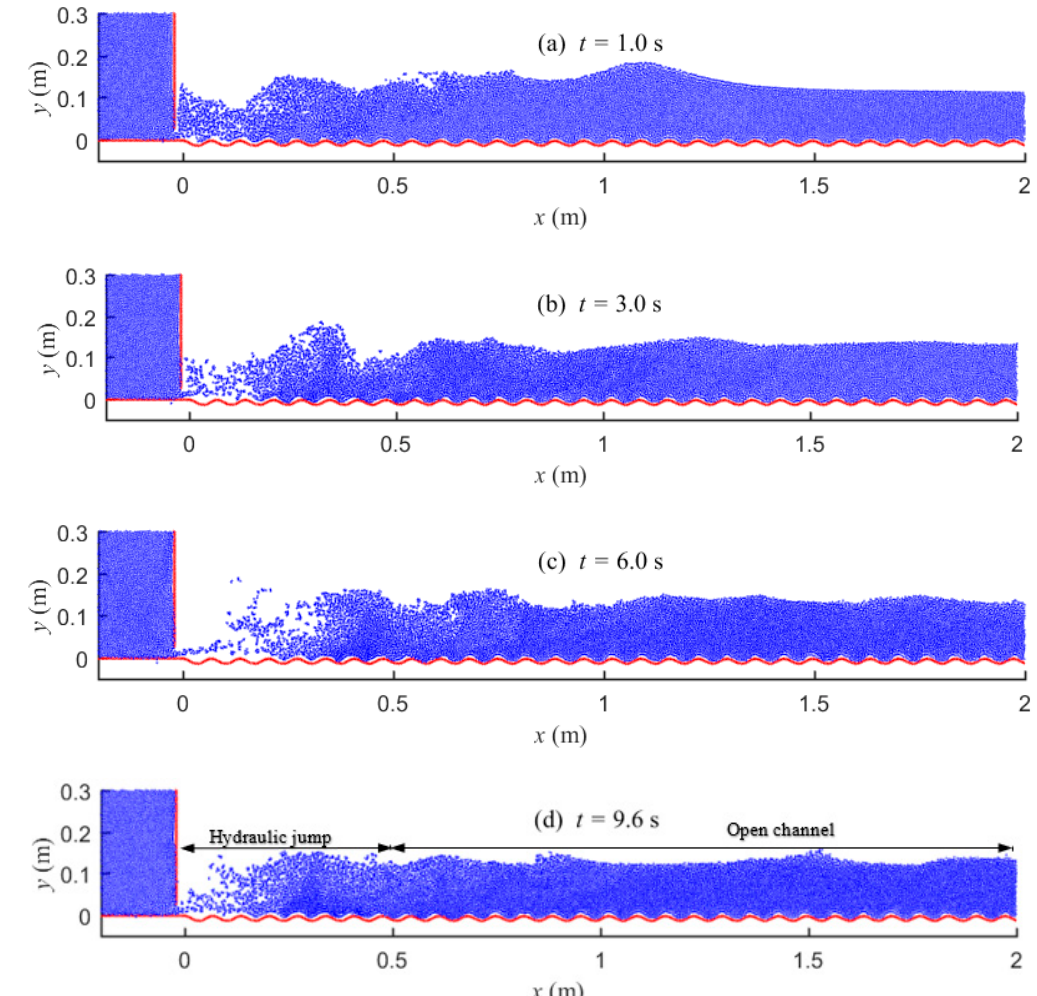
Figure 4. Snapshots of hydraulic jump evolvement.